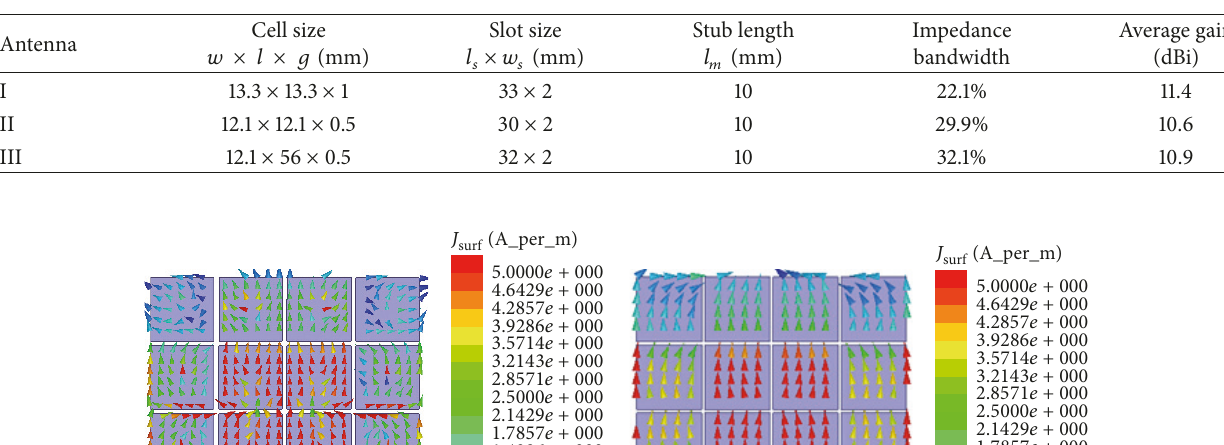
Figure 2: Simulated reflection coefficients and gains of the three slot-fed antennas with different MPs. (a) Reflection coefficients. (b) Antenna gains. Table 1: Antenna dimensions, bandwidths, and average gains of antennas.